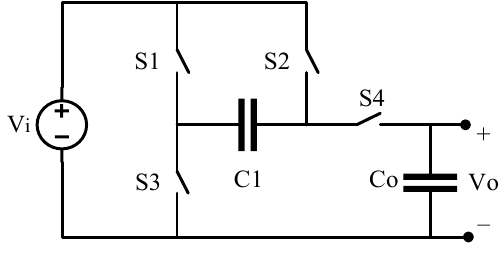
Figure 2. Figure 2. SCVD.